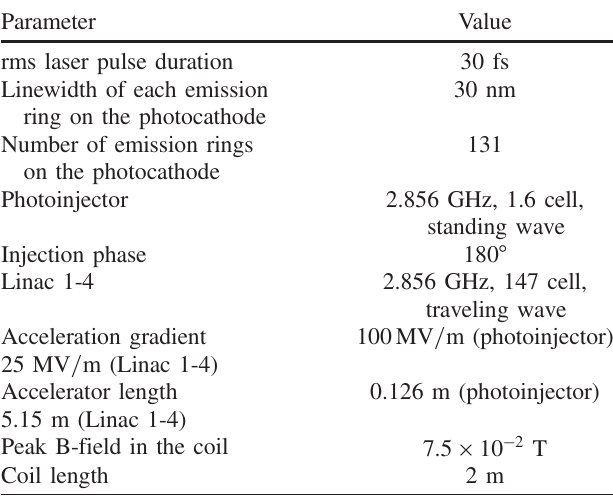
TABLE I. Parameters of the NCRF accelerator system in Fig. 5.